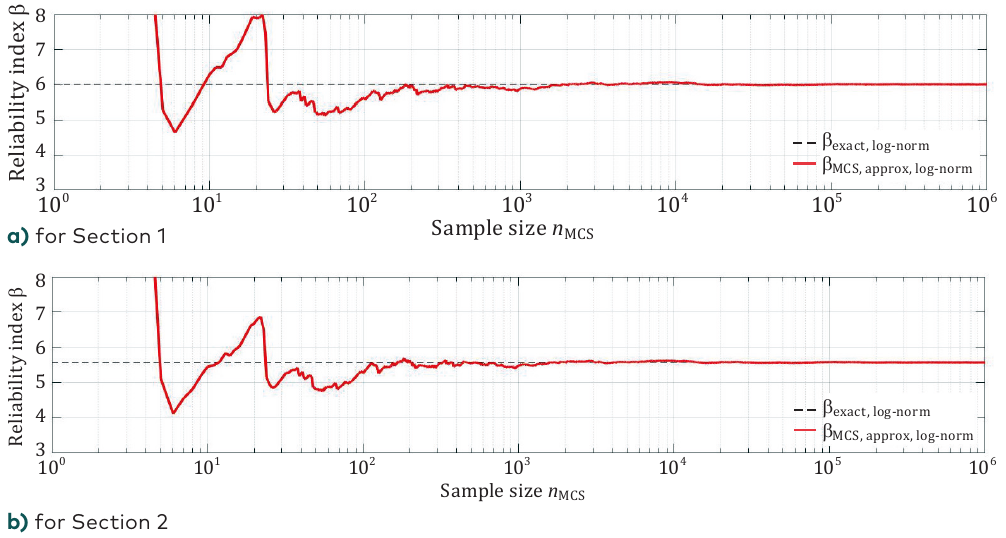
Figure 10. Reliability index distribution versus the simulation